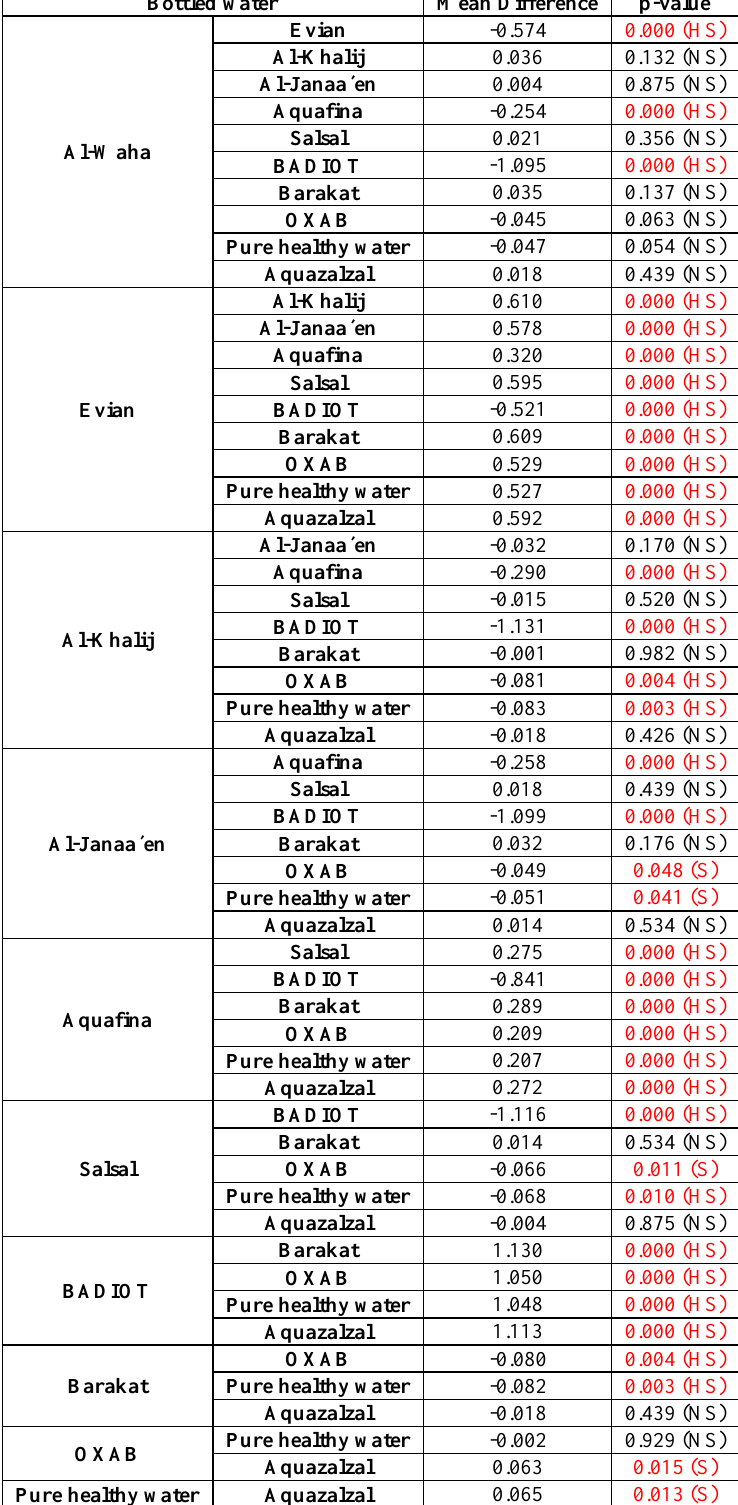
Table 2: LSD Test after ANOVA Test